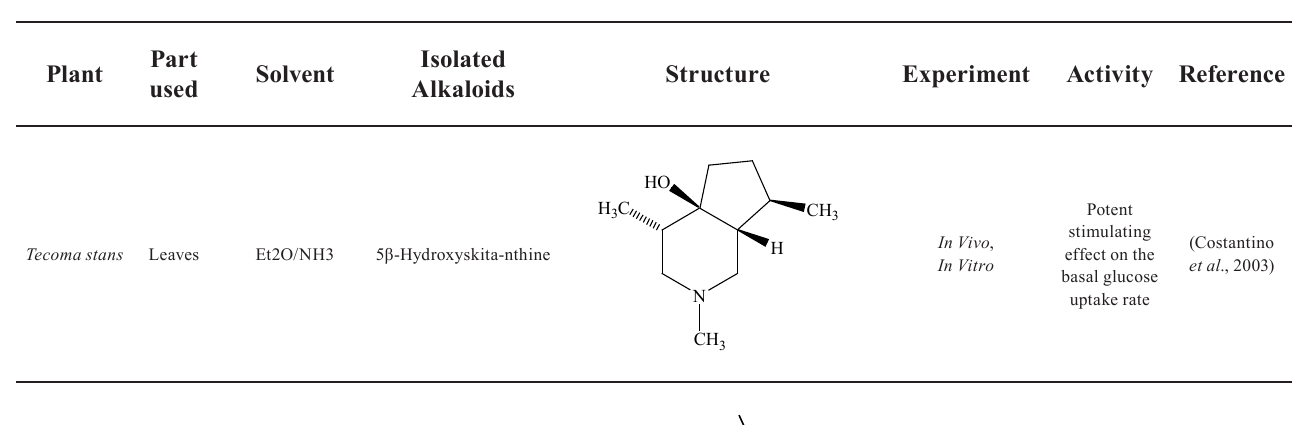
TABLE I – A lkaloids with anti-diabetic activity